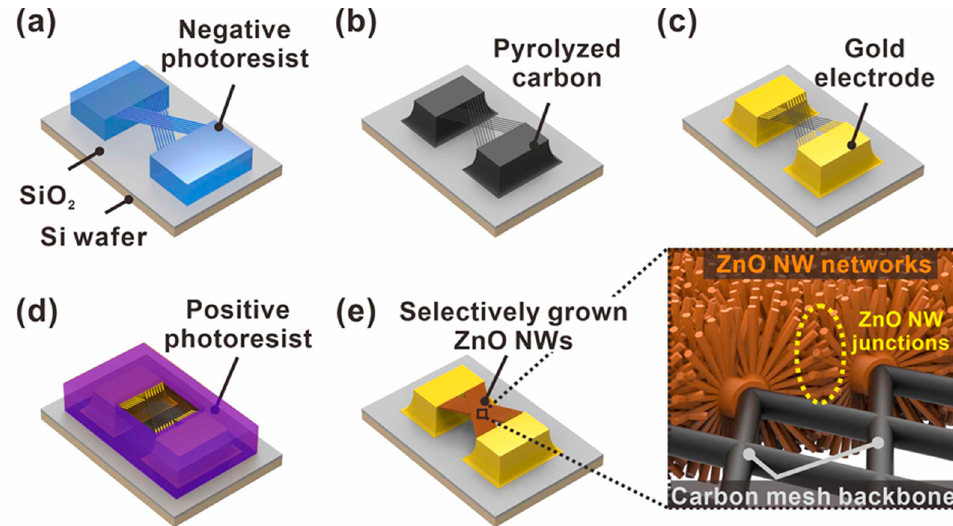
Figure 1. Schematic of the fabrication steps of suspended carbon nanomesh functionalized with ZnO NW networks. ( a ) Suspended polymer micromesh patterned by two-step photolithography; ( b ) conversion from polymer to carbon structures by pyrolysis; ( c ) gold electrode patterning; ( d ) selective exposure of suspended carbon mesh via photolithography; ( e ) selective integration of ZnO NW networks via ZnO seed layer deposition and hydrothermal growth processes (enlarged image: ZnO NW junctions with embedded carbon nanomesh backbone).